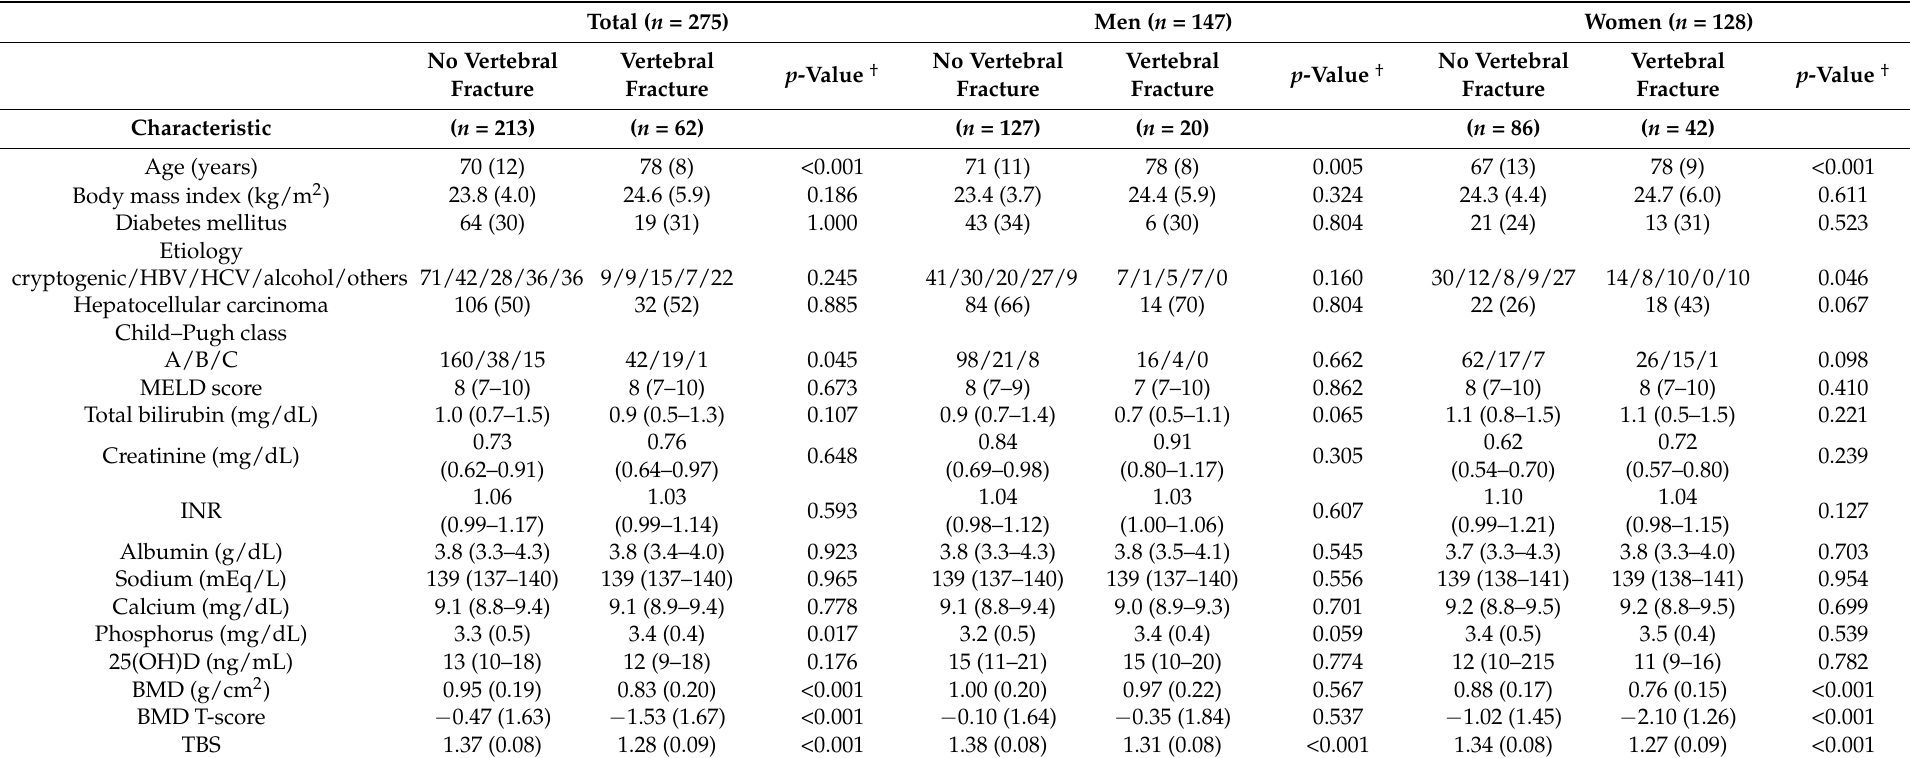
Table 2. Clinical characteristics of the presence or absence of vertebral fractures in the total cohort and in each